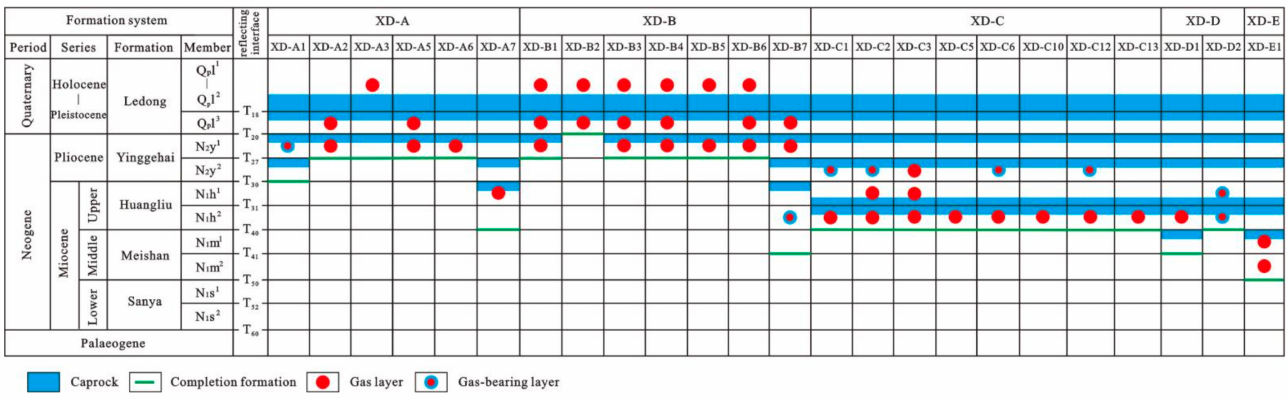
Figure 3. Vertical distribution of gas in diapir zone and slope zone in Yinggehai